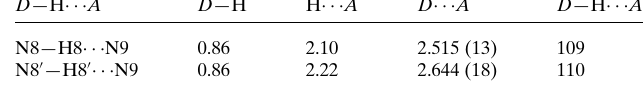
Table 2 Selected geometric parameters (A˚ , (cid:5) ) for 2 .